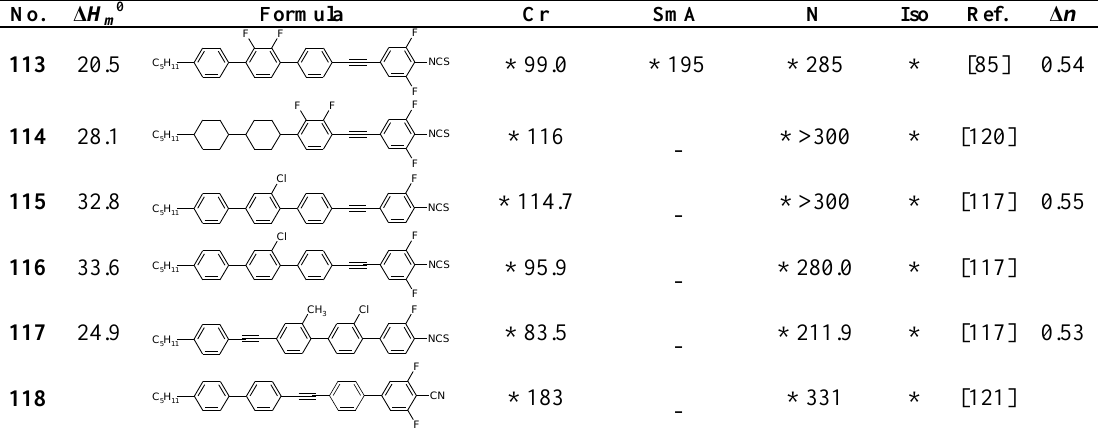
Table 15. Phase transition temperatures [°C], melting enthalpies [kJ/mol] and birefringence of four-ring compounds with the triple bond.